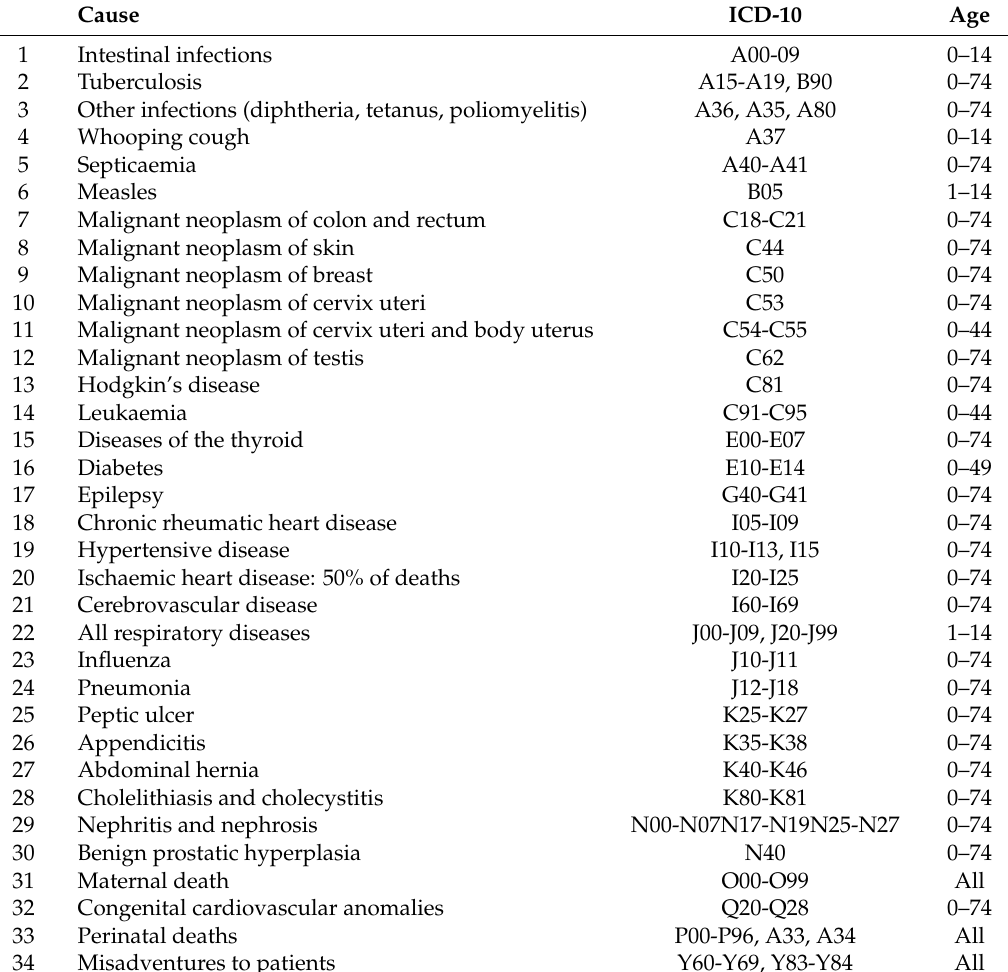
Table 1. ICD-10 classification code and age range for the amenable causes